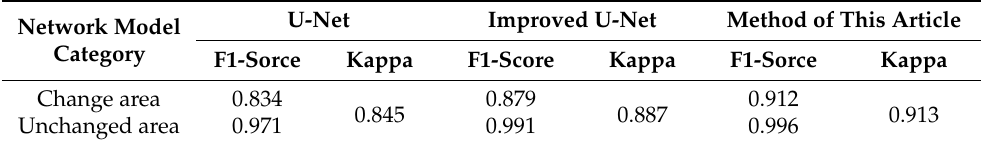
Table 6. Accuracy evaluation of different